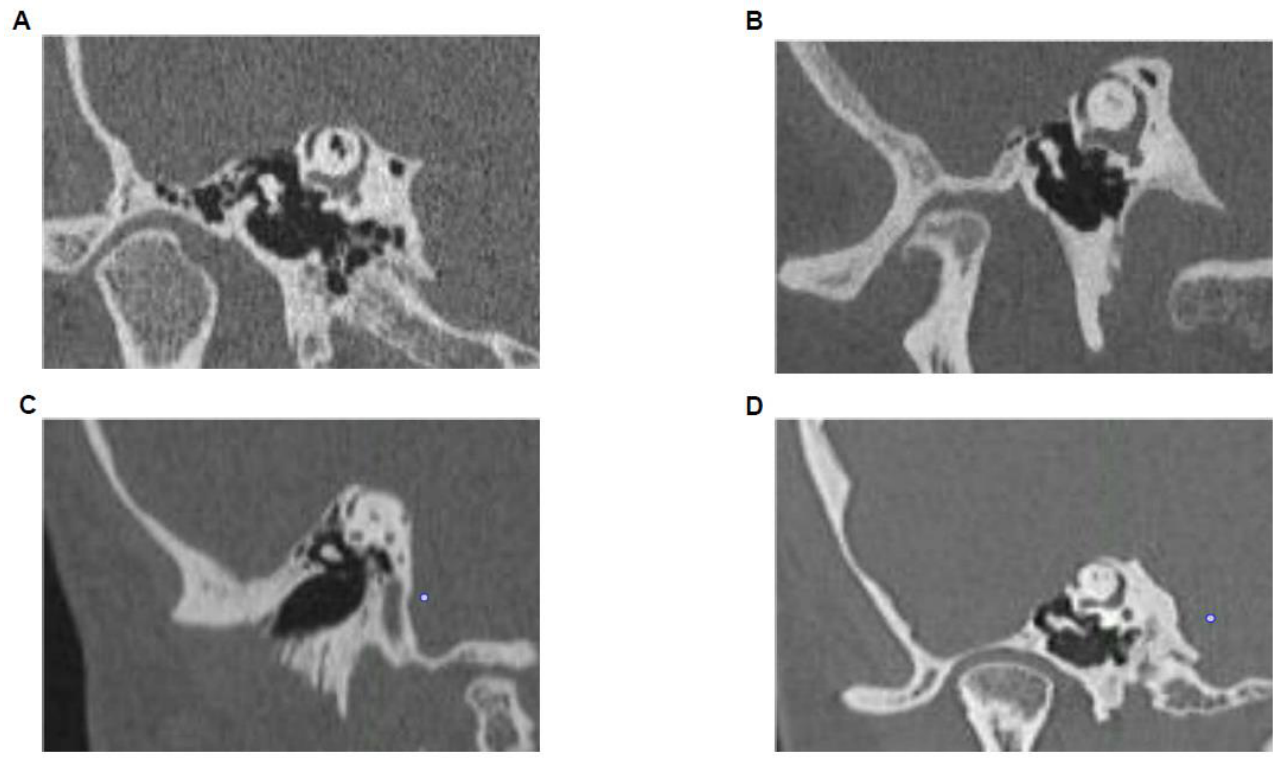
Figure 2. CT-Scan image representing each location. ( A ) Superior; ( B ) anterior; ( C ) posterior superior; ( D ) anterior superior.